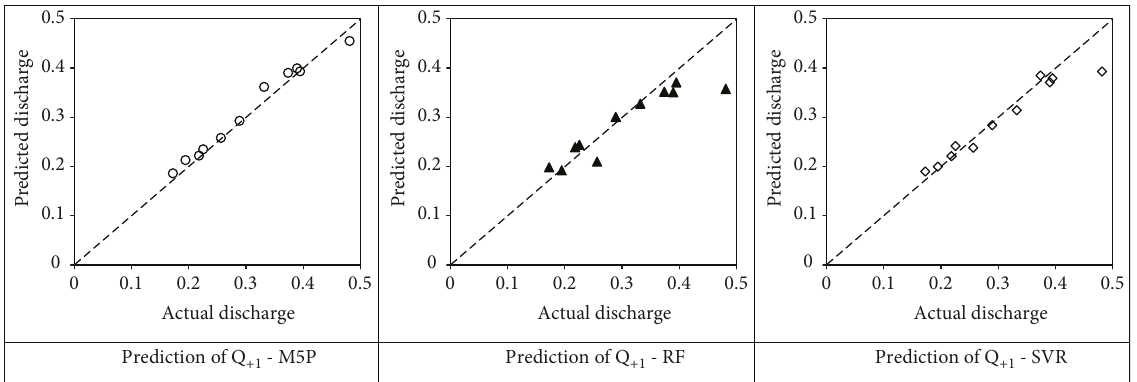
Figure 8: Comparison between predicted and observed discharges (m 3 /s), 4-month input.